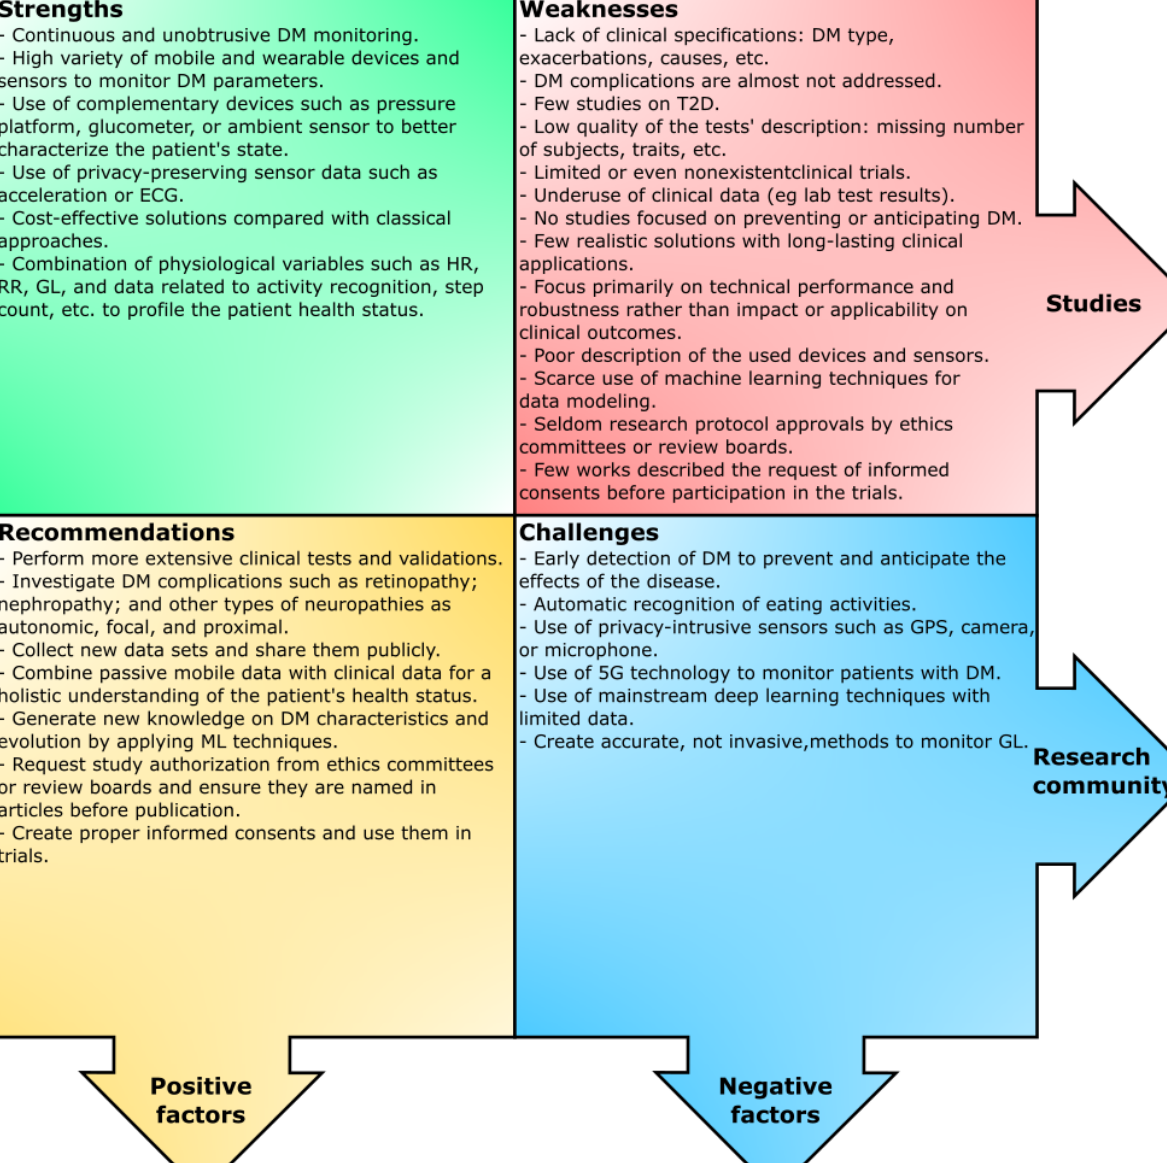
Figure 2. Summary of the principal findings of the reviewed manuscripts. DM: diabetes mellitus; ECG: electrocardiogram; GL: glucose level;